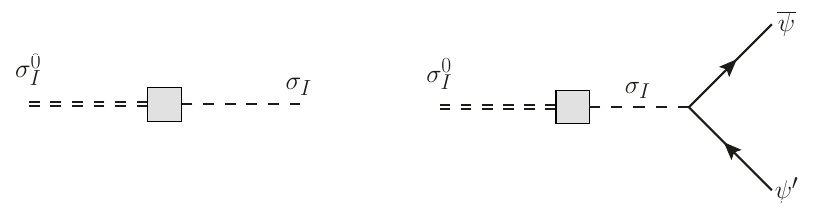
Figure 3 . The zero mode decay processes. The gray box denotes the vertex from the string curve c ( r, θ, z ) . (Left) The conversion to the bulk massive mode. (Right) The two-body decay to light modes. This process is not present in the U(1) × ˜U(1) model, but naturally occurs, e.g. for the DFSZ superconducting